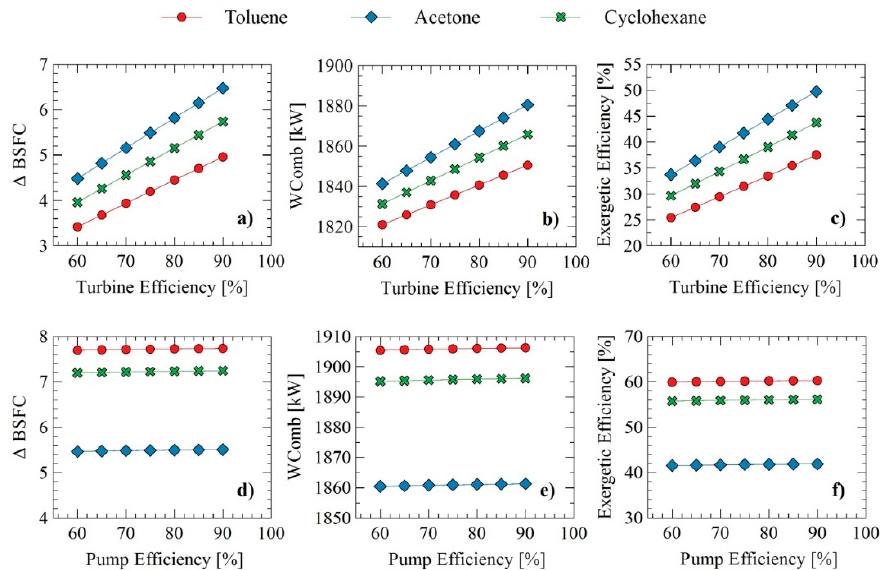
Figure 7. E ff ect of the turbine and pump e ffi ciency on ( a , d ) ∆ BSFC, ( b , e ) Wcomb, and ( c , f ) exergetic Figure 7. Effect of the turbine and pump efficiency on ( a , d ) ∆ BSFC, ( b , e ) Wcomb, and ( c , f ) exergetic e ffi ciency using toluene, acetone, and cyclohexane as working fluid. efficiency using toluene, acetone, and cyclohexane as working fluid.